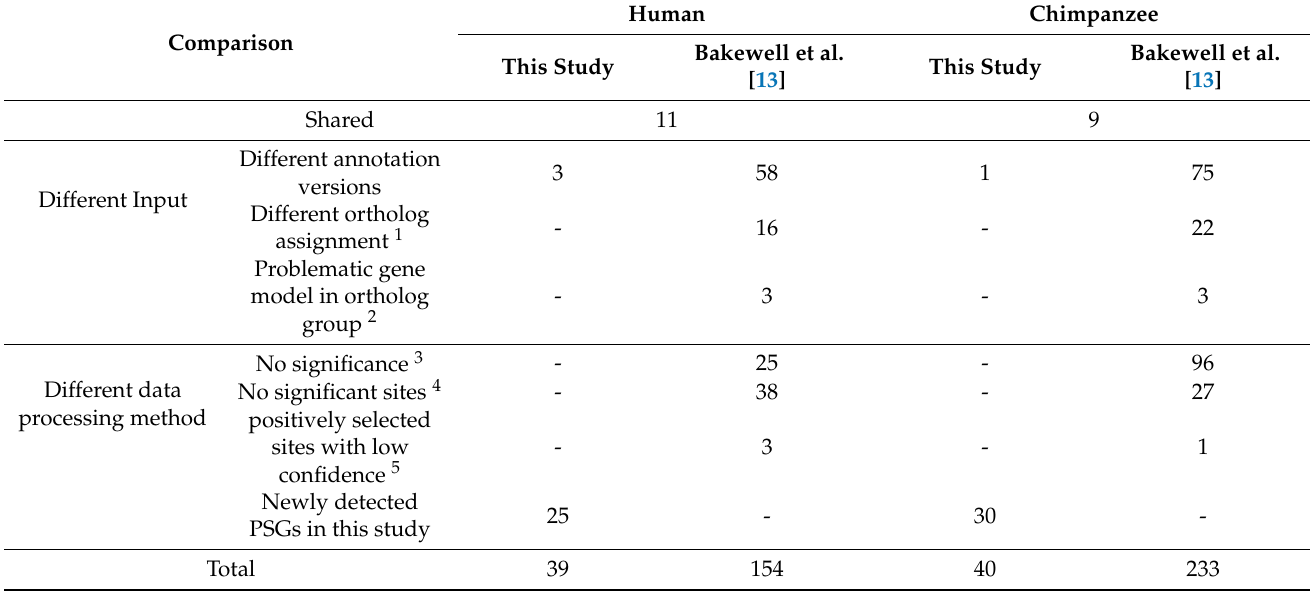
Table 4. Comparison of the PSGs identified by this study vs. Bakewell et al.